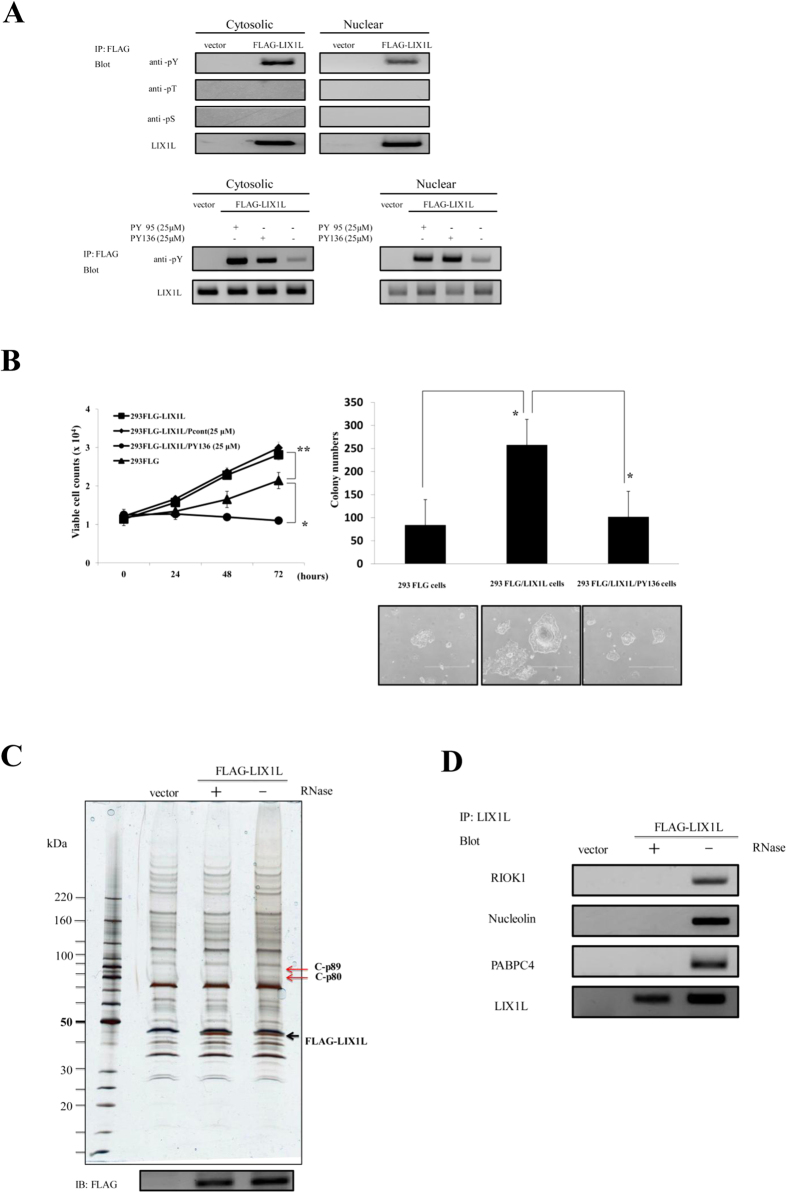
LIX1L-mediated oncogenic effects and identification of LIX1L-associated proteins using a proteome analysis.(A) Phosphorylated LIX1L was immunoprecipitated from the cytosolic and nuclear fractions of HEK-293FLG and HEK-293FLG-LIX1L cells using a FLAG antibody. Immunoprecipitates were analyzed through western blot analysis with a LIX1L antibody and phosphorylated serine-, threonine- and tyrosine-specific antibodies (upper panels). In the cytosolic and nuclear fractions of the HEK-293FLG and HEK-293FLG-LIX1L cells treated with 25 μM PY95 as a negative control or PY136, immunoprecipitates obtained using the FLAG antibody were analyzed through a western blot analysis with the LIX1L antibody and phosphorylated tyrosine-specific antibodies (bottom panels). Representative blots from HEK-293FLG and HEK-293FLG-LIX1L cell lines are shown. (B) The cell counts of HEK-293FLG and HEK-293FLG-LIX1L cells after treatment with PY136 (left panel). The HEK-293FLG and HEK-293FLG-LIX1L cells were cultured in semisolid methylcellulose media. The HEK-293FLG-LIX1L cells were left untreated or were treated with PY136 (25 μM). After 14 days in culture, colony formation was analyzed, and the cells were viewed using phase-contrast microscopy. The colonies formed from each cell type (3 × 102 to 5 × 102 cells/plate) were counted following plating onto semisolid methylcellulose media (right upper panel). Original magnification 4x (right bottom panels). These data are shown as the mean ± SD for independent experiments. **p < 0.05, *p < 0.01. (C) The results of the immunoblot analysis of the cytosolic fraction treated with or without RNase in HEK-293FLG-LIX1L cells. The black arrow indicates the FLAG-LIX1L fusion protein. The red arrows indicate the detected proteins associated with the LIX1L-RNA complex. (D) Western blot analysis revealed that LIX1L interacted with the RIOK1, nucleolin and PABPC4 proteins in the cytoplasm of HEK-293 cells. In (A) and (D), the cropped blots were run under the same experimental condition.